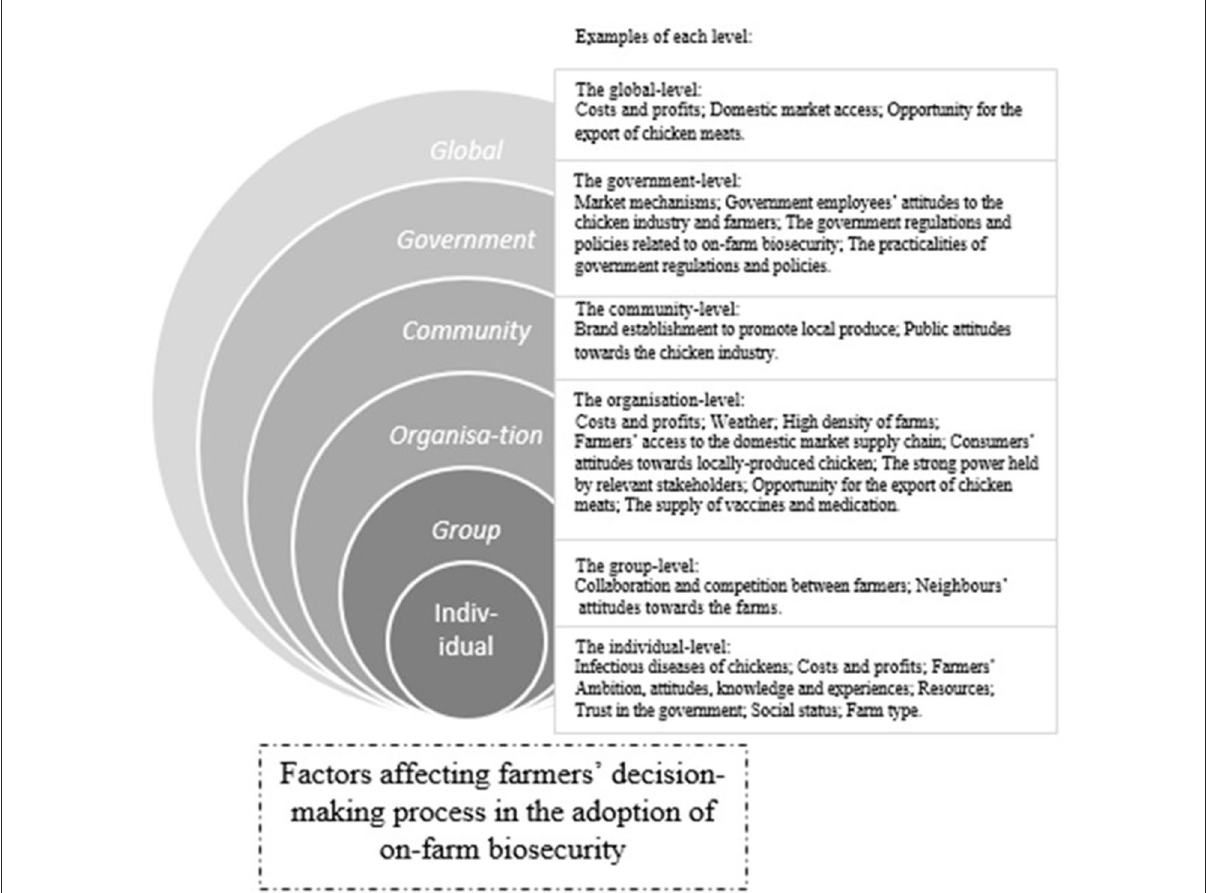
FIGURE3 An exploratory social-ecological model of factors affecting farmers’ decision on biosecurity. A modified six-level social structure was constructed to explore farmers’ decisions for the implementation of biosecurity at farm level. The model explains the complex influences of macro socio-economic conditions on farmers’ biosecurity behaviours; global effects were also